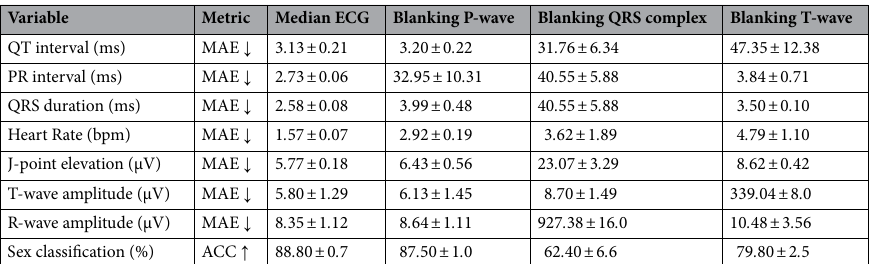
Table 3. Mean absolute error (MAE) and accuracy (ACC) ± standard deviation measured on the replication dataset when blanking specific waves of a median heartbeat. Prediction errors increased dramatically when the feature in question is blanked out. Prediction errors also often increased slightly when other parts of the ECG are blanked. In the metric column, the arrow signifies whether higher or lower values are better, i.e., an arrow pointing downwards means that lower values are